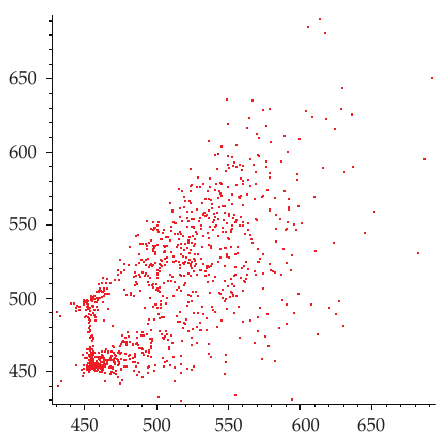
Figure 4: (cid:2) y (cid:2) t − 1 (cid:3) ,y (cid:2) t (cid:3)(cid:3) in the stochastic case for d (cid:7) 0.